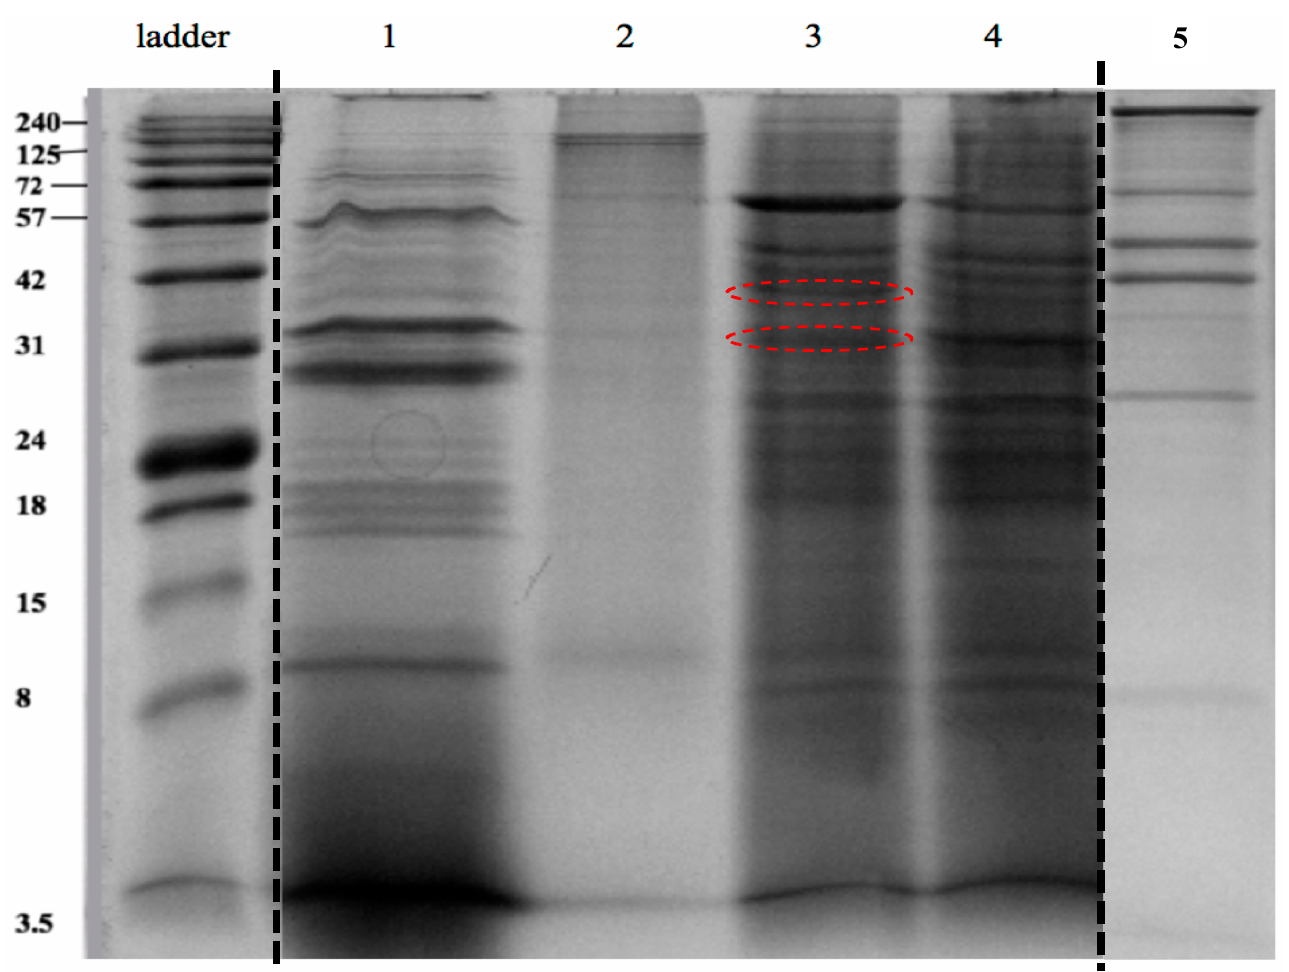
Figure 5. Identification of the dentin collagen degradation products following digestion with the extracted intracellular proteins of S. mutans UA159. Lane 1: positive control (dentin collagen samples incubated with C. histolyticum collagenase); lane 2: negative control (dentin collagen samples incubated in PBS); lane 3 and 4: experimental groups (dentin collagen samples incubated in intracellular proteins at 37 °C for 2 weeks); lane 5: intracellular protein extracted from S. mutans (baseline control). Extra groups were cut off from the same gel image between the ladder and Lane 1; Lane 5 (baseline control) was regrouped from another gel. Red circles indicate the most distinct bands of interest from experimental groups.